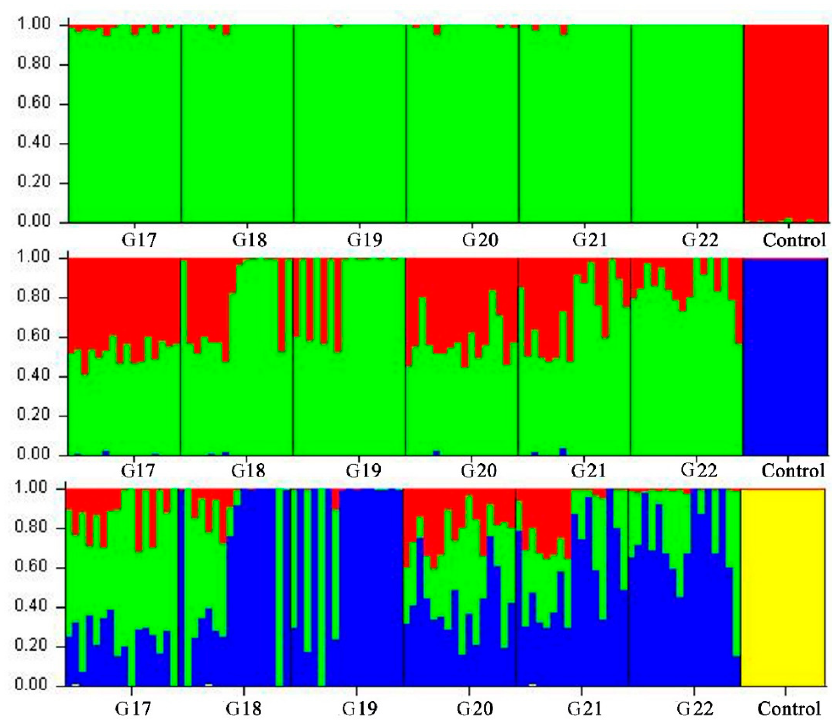
Figure 3. Population genetic structure and admixture estimation in 96 inbred WZSPs and the non-inbred population. From the top to the bottom is the clustering of 108 individuals when K = 2, 3, and 4, respectively. Individuals are shown as a thin vertical line colored in proportion to their estimated ancestry.